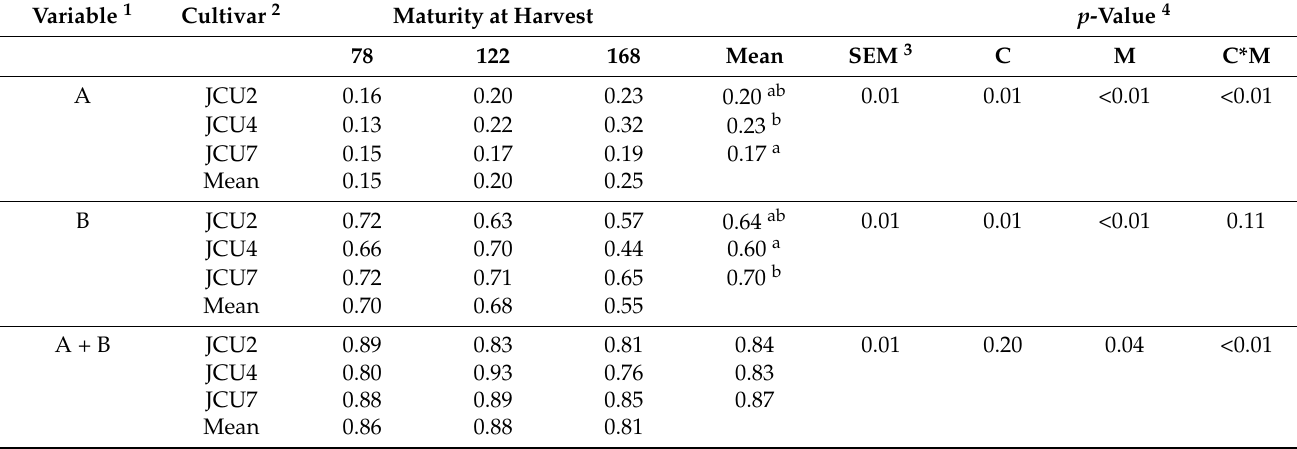
Table 5. Effect of cultivar and maturity stage at harvest of desmanthus on in situ crude protein (CP) degradation. Data presented in fractions unless otherwise